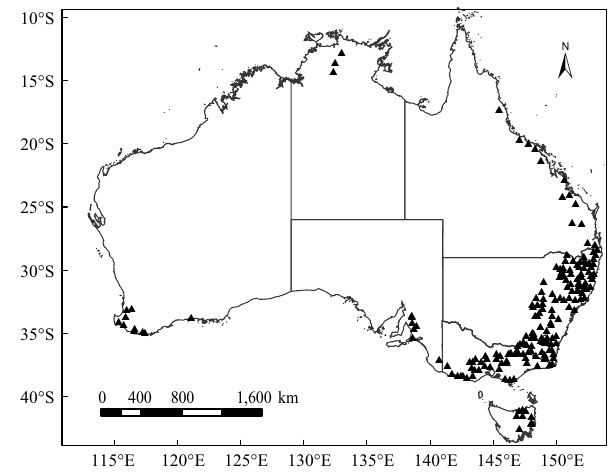
Fig. 1. Distribution of the 193 study catchments (the triangle placed in the outlet of each